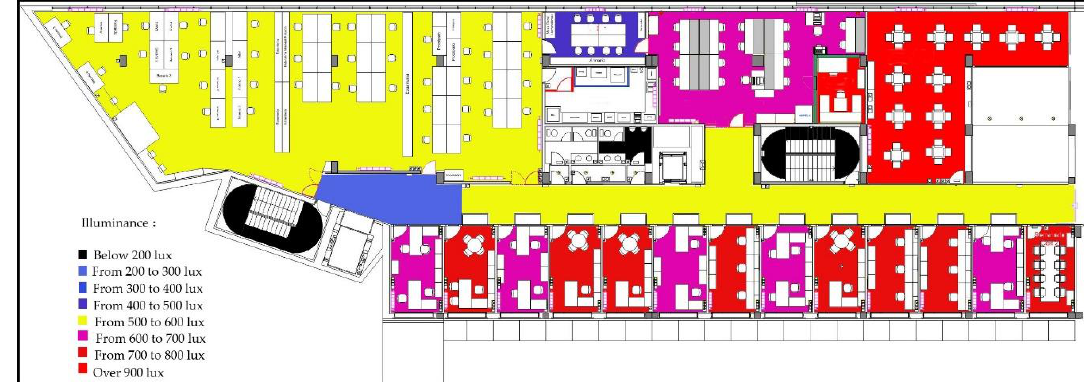
Figure 2. Illuminance level mapping of a research institute building’s floor.